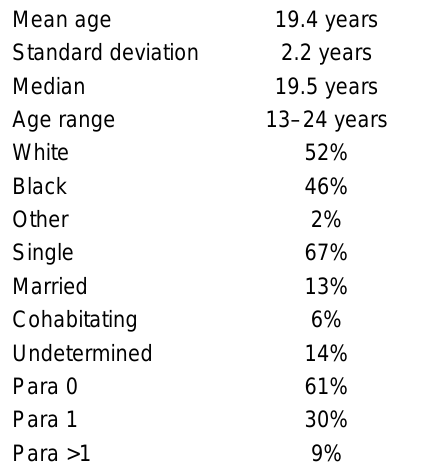
Demographic Characteristics of Patients Included in the